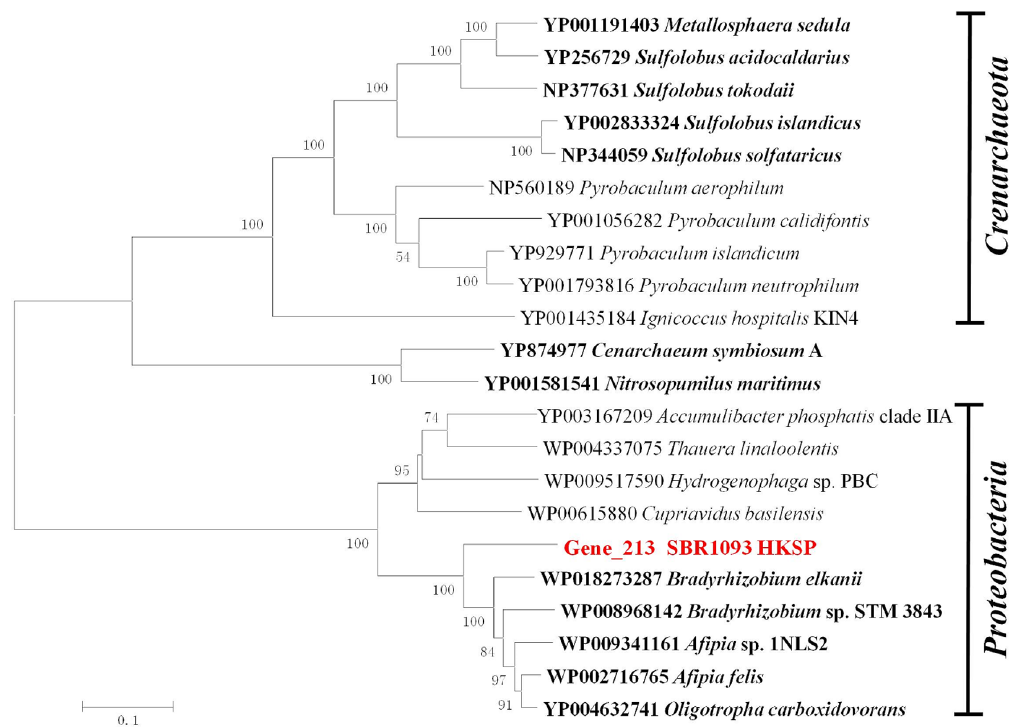
Figure 4. Phylogenetic tree of 4-hydroxybutyryl-CoA dehydratase proteins. The 4-hydroxybutyryl-CoA dehydratases in this draft genome and others in identified autotrophic Achaea were retrieved from NCBI to build the phylogenetic tree. The hosts of these marked (in bold) are suspected autotrophic microbes that undergo the HPHB cycle. The number in front of the taxonomy presents the accession number in NCBI. The tree topography and evolutionary distances are given via the neighbor-joining method with a Poisson correction. The numbers at the nodes indicate the percentage bootstrap values for the clade of this group in 1,000 replications. The scale bar represents a difference of 0.1 substitutions per site.